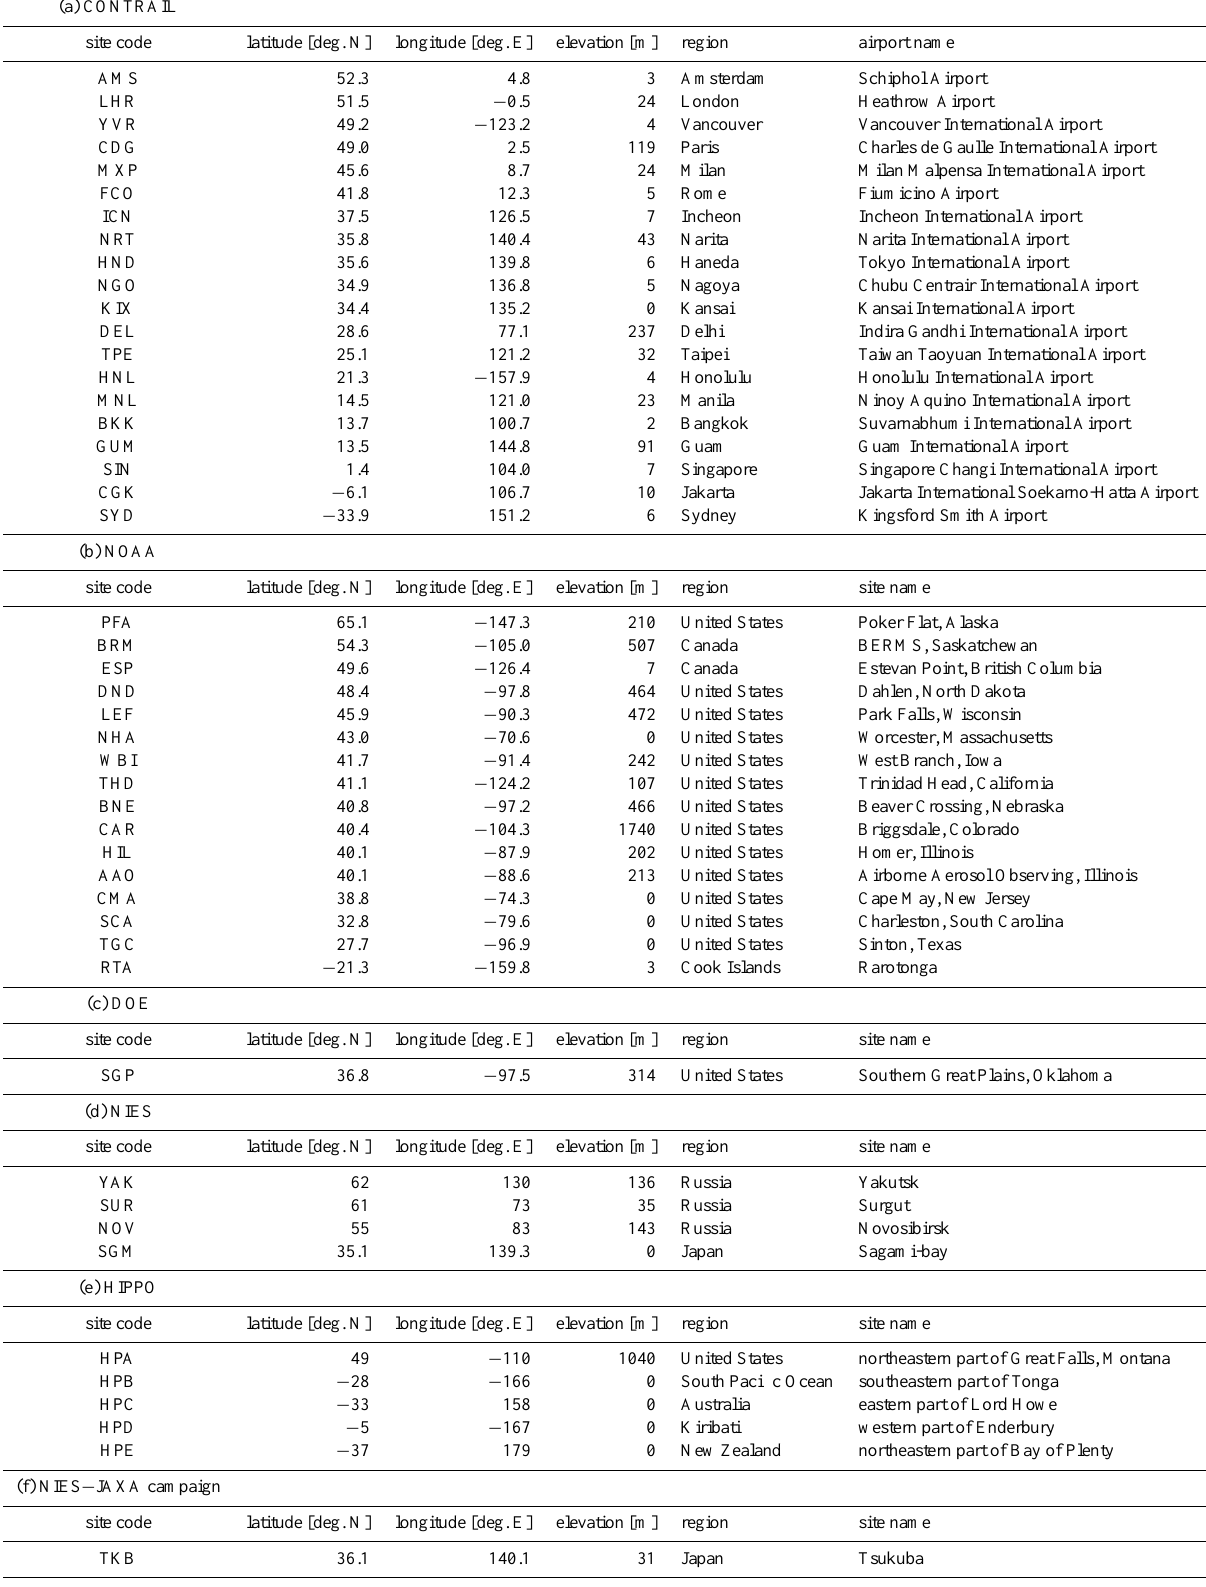
Table 1. Basic information for the aircraft measurement sites used for the GOSAT validation. (a) CONTRAIL site code latitude [deg. N]